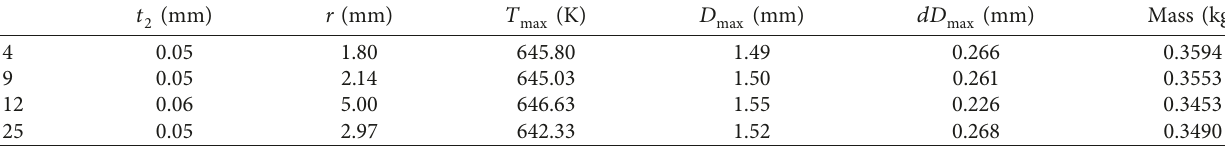
Table 13: Comparison of preferred individuals in the 2nd stage optimization.